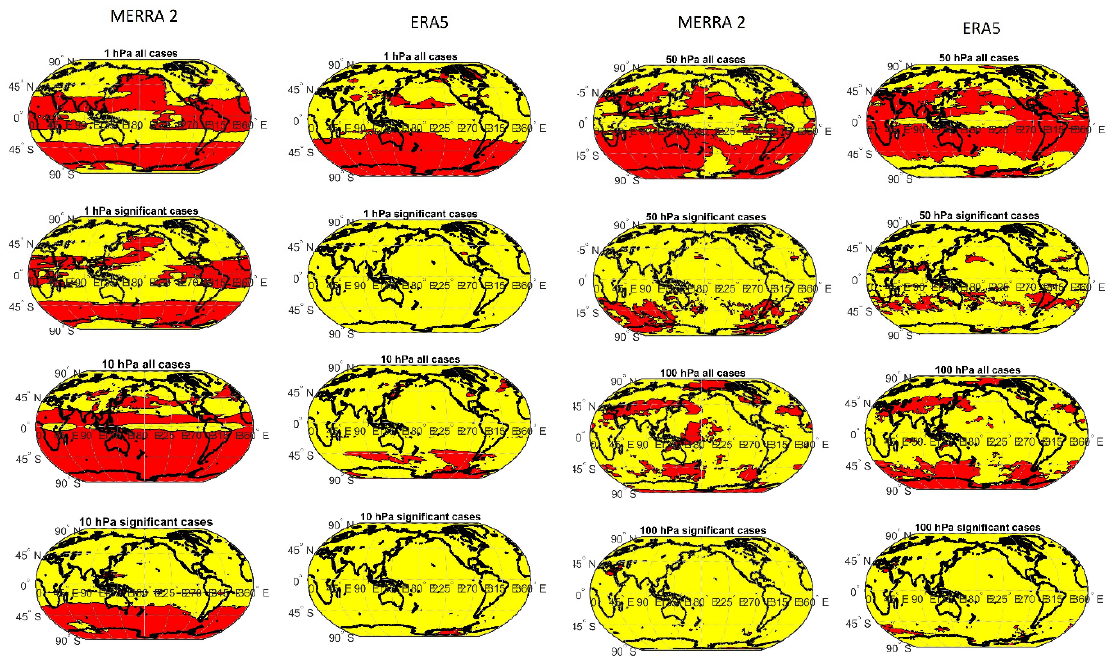
Figure 5. Geographical distribution of jumps for MERRA2 and ERA5 at different pressure levels (1, 10, 50, and 100 hPa) for February. Significant cases mean the application of the variance condition. Red means grid point with identified jump.